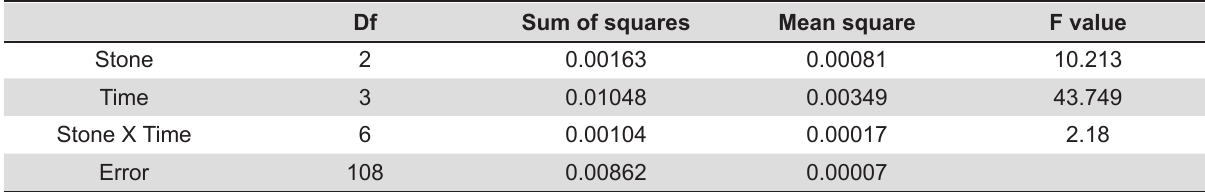
Table 1- Variance analysis